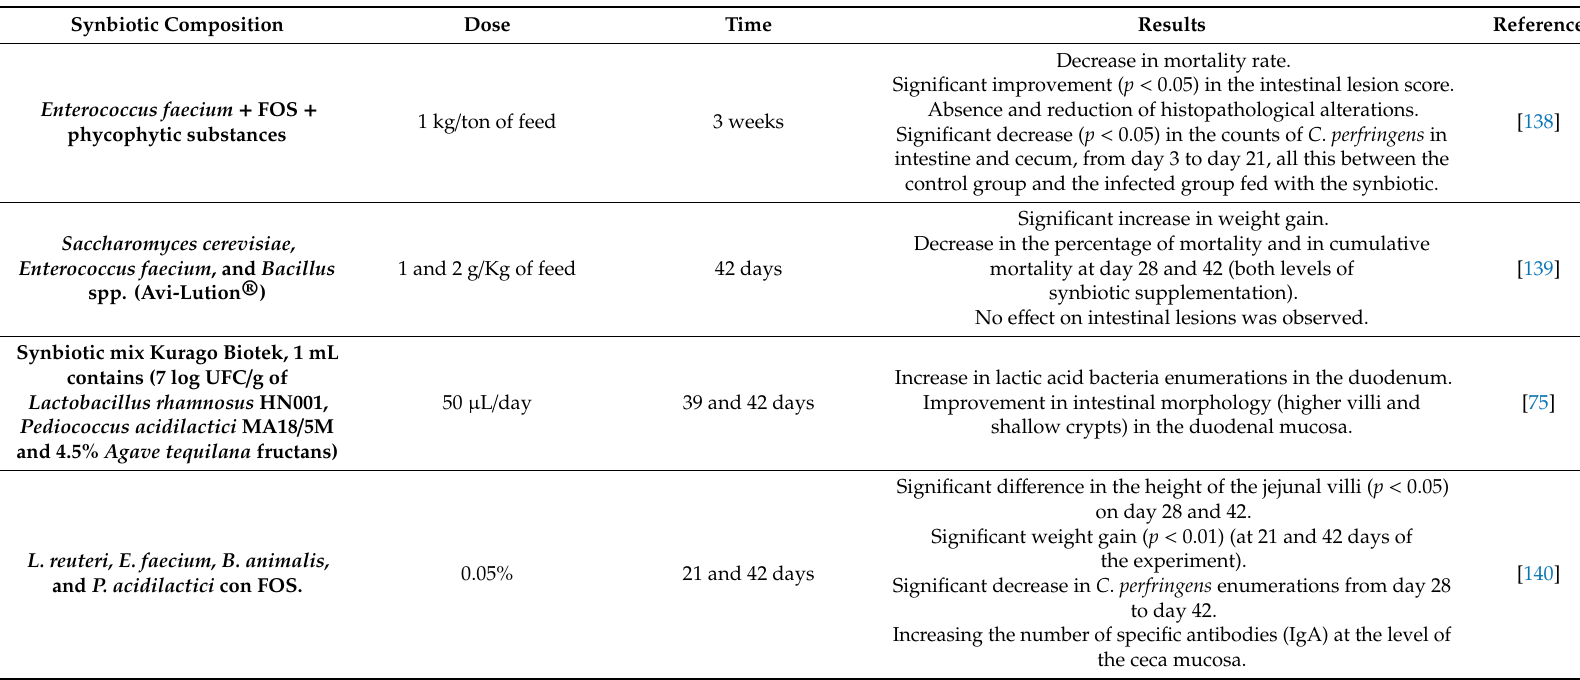
Table 7. E ff ect of the use of symbiotics on health, production parameters and the elimination of Clostridium perfringens in